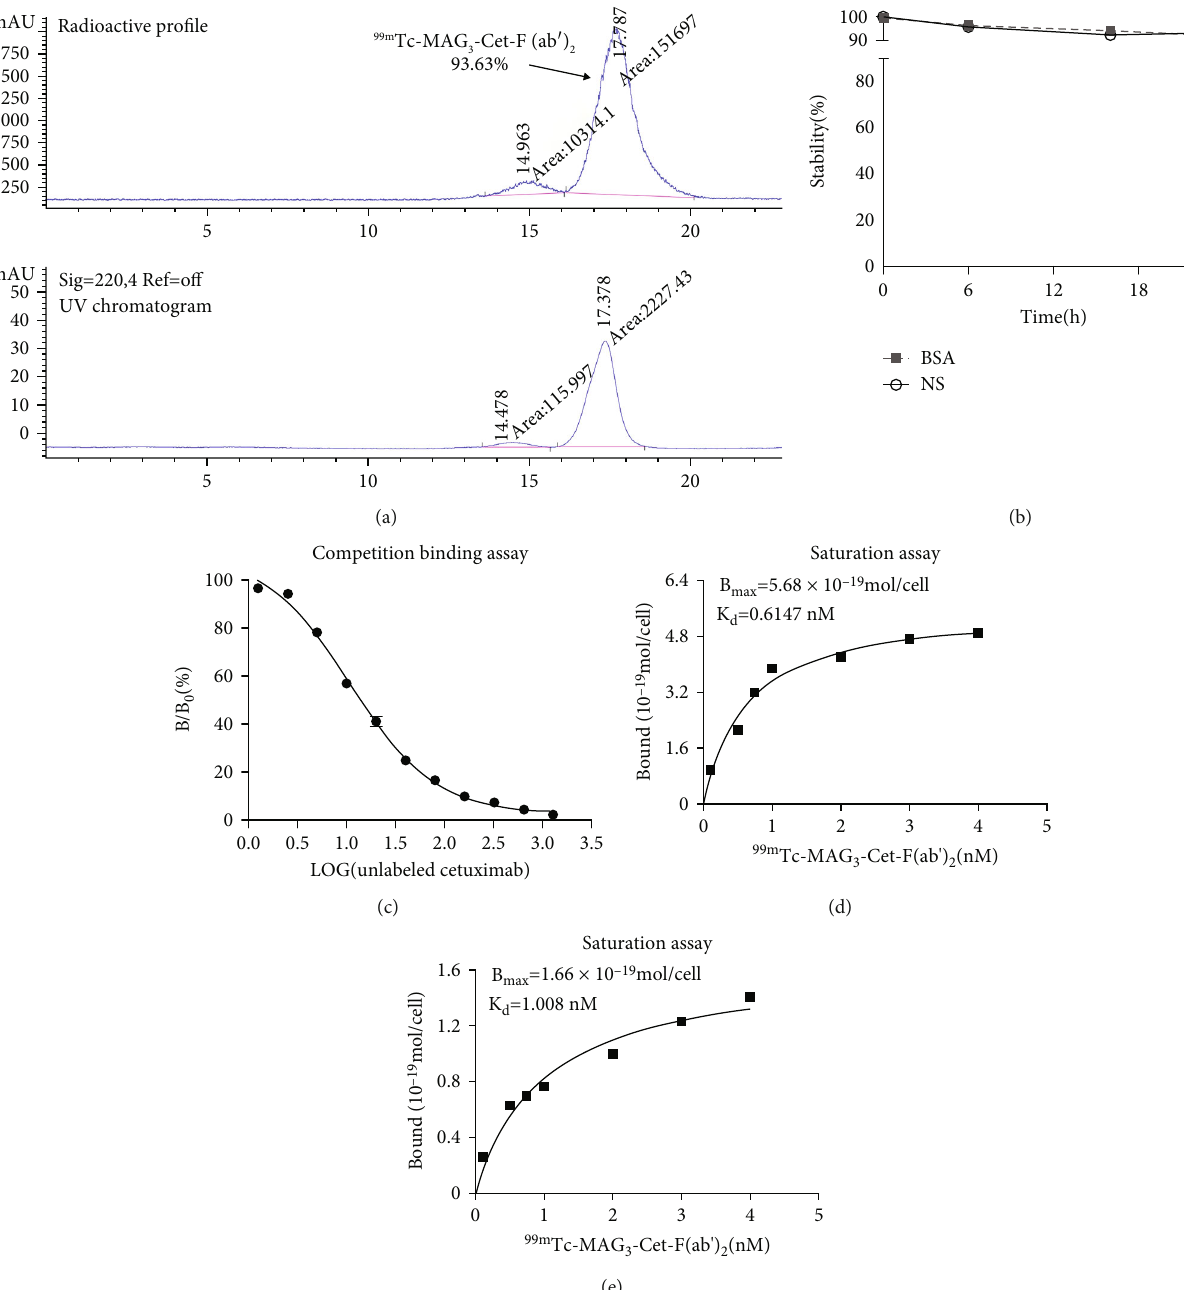
Figure 5: Characterization of 99m Tc-MAG3-Cet-F(ab ′ ) of 99m Tc-MAG -Cet-F(ab ′ ) in 1% BSA and NS. (c) Competition binding assay between 99m Tc-MAG 3 2 to MGC803 cells (d, e). Representative saturation binding curve of 99m Tc-MAG (e), indicating its higher a ffi nity to MGC803 cells ( B ( B = 1 : 66 × 10 − 19 mol ligands/cell, Kd = 1 : 008nM max